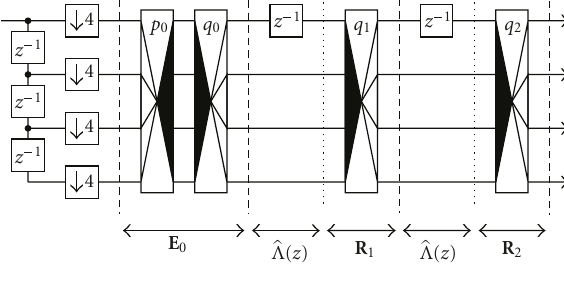
Figure 6: Quaternionic lattice structure for 4-channel general PUFB ( N =